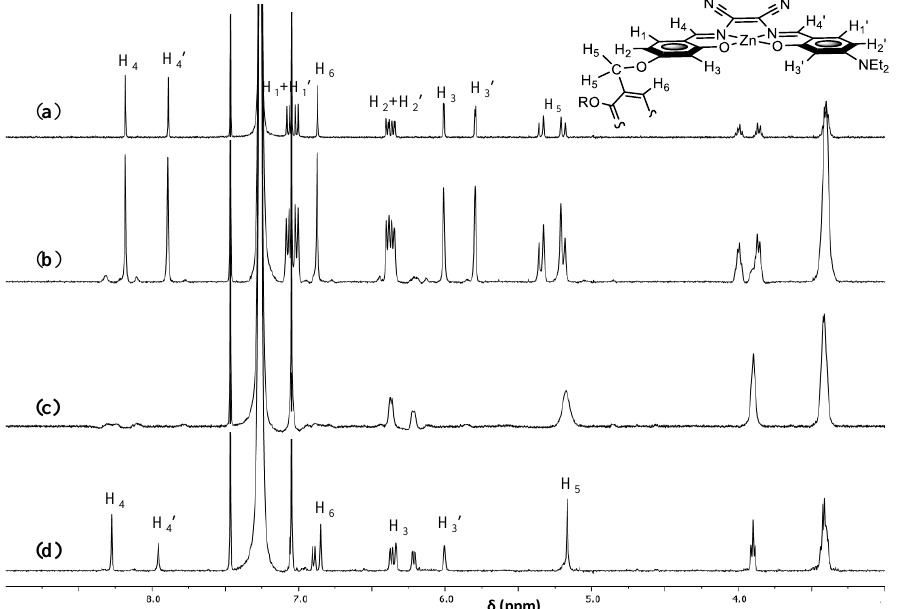
Figure 3. 1 H NMR titration spectra of 1 (50 µ M in CDCl 3 ( a )) with addition of 1,10-diaminodecane. The concentration of 1,10-diaminodecane added was 25 µ M ( b ), 50 µ M ( c ), and 200 µ M ( d ). For assignment of 1 H NMR signals of the aggregate 1 . Adapted from ref. [45].